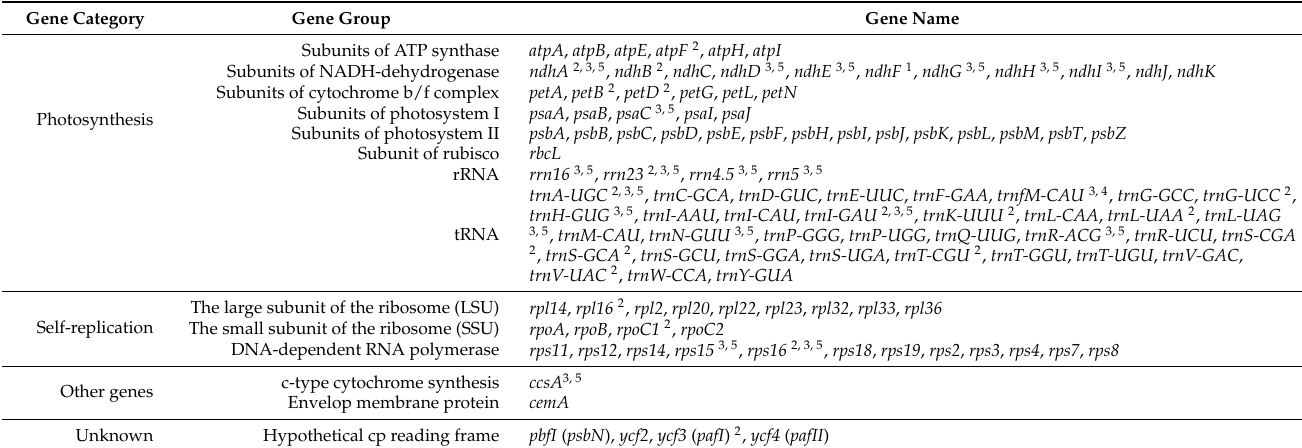
Table 2. Genes present in V. floribundum cp